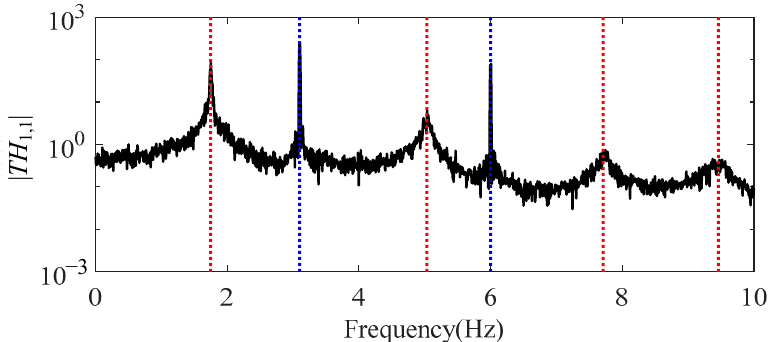
Figure 7. Natural frequency indication curve of TH 1,1 ( s ) . The delayed TRF 34 ij t ( i = 1, 2, ..., 19; j = i + 1) of the acceleration response of DOF 3